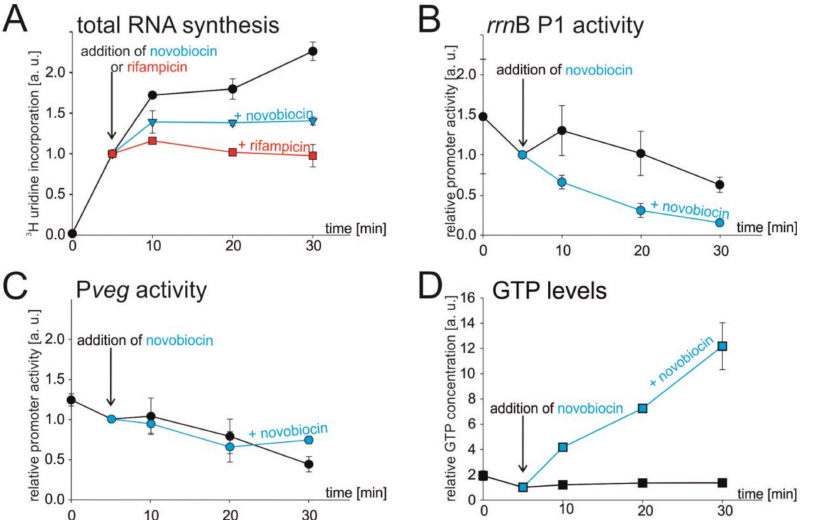
Figure 2. Effect of novobiocin-induced relaxation of chromosome on total RNA synthesis, selected promoter activities, and GTP level. ( A – D ) Cells were grown to early exponential phase (OD 600 ~0.3), and at time 5 min they were treated with novobiocin (5 µ g/mL). ( A ) Total RNA synthesis after novobiocin treatment. After 3 H-uridine had been added (time 0), the culture was divided into three flasks. At time 5 min the cells were treated with novobiocin (blue line) or with rifampicin (red line) as a control, or left untreated (black line). The amount of radiolabeled RNA at 5 min was set as 1. Black circles, mock-treated; blue triangles, treated with novobiocin; red squares, treated with rifampicin. The values are averages of three independent experiments ± SD. ( B , C ) The relative activities of rrn B P1 and P veg promoters after novobiocin treatment. Cells were grown and at 5 min treated with novobiocin or not. RNA was extracted and determination of promoter activity was done by RT-qPCR. Promoter activities were set as 1 at time 5 min. Blue lines are novobiocin-treated samples, black lines are untreated samples. The experiment was performed three times. The error bars show ± SD. ( D ) GTP concentration after novobiocin treatment. Cells were grown in the presence of [ 32 P] H 3 PO 4 and treated with novobiocin. Levels of GTP were determined by TLC. The GTP level at 5 min was set as 1. Results are averages from two measurements. The error bars show the